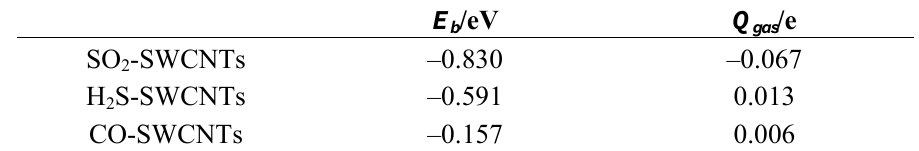
Table 2. Adsorption energy and charge transform of intrinsic SWCNTs adsorption.